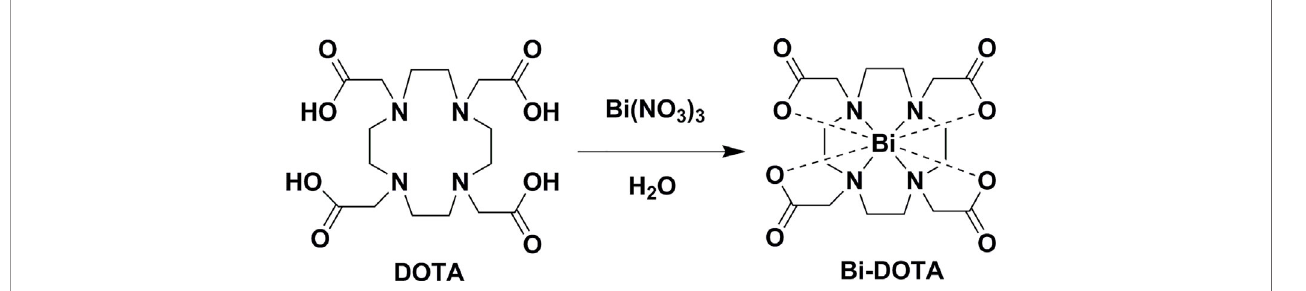
SCHEME 1 | Schematic representation of the synthesis